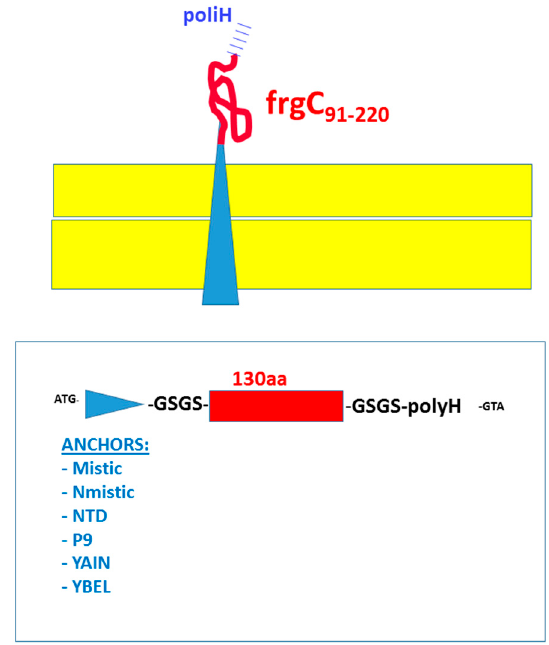
Figure 2. Scheme of the genetically fused constructs for bacterial surface expression of frgC 91–220.